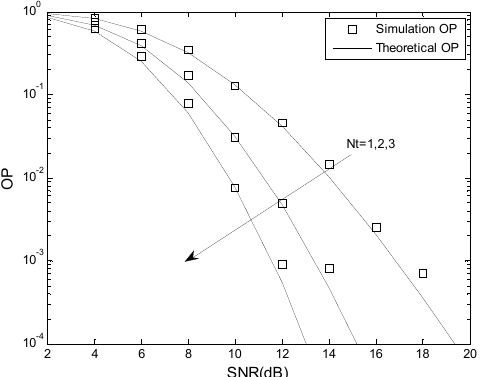
Figure 6. The OP performance of the suboptimal TAS scheme when γ th < γ P .